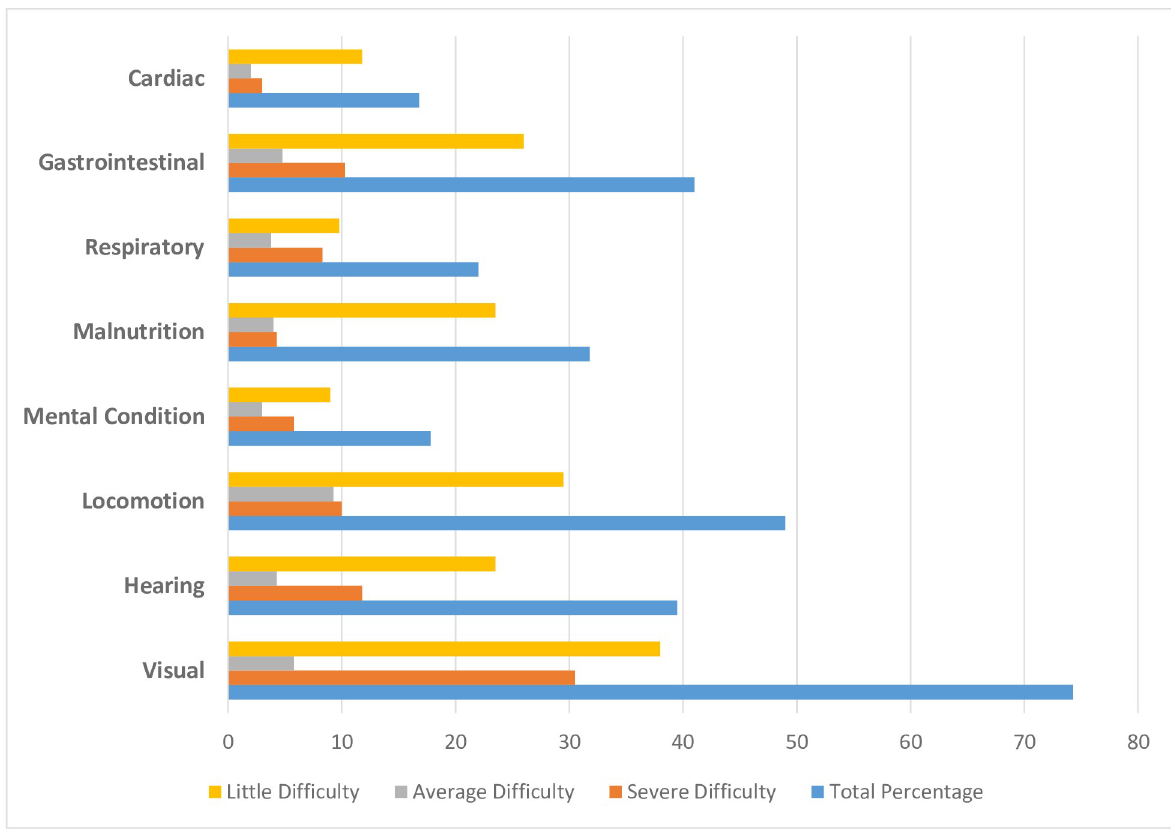
Fig 2. Distribution of chronic conditions of indigenous older adults with their level of